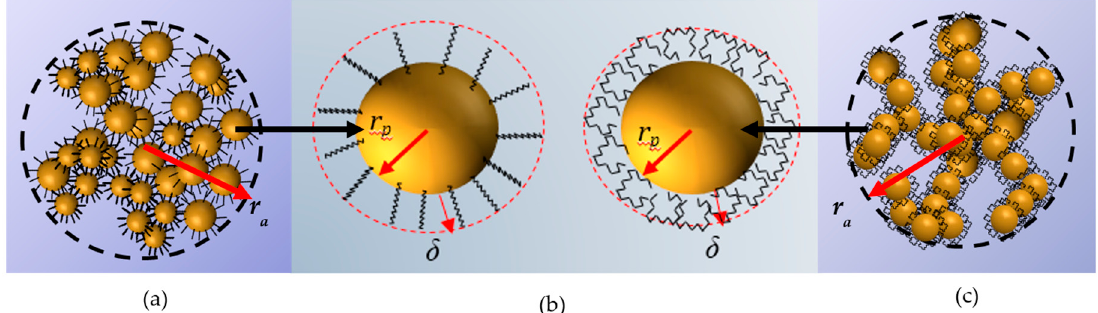
Figure 4. ( a ) Representation of an agglomerate of R816 fumed silica particles in PPG400. ( b ) The hexadecyl silane conformation adopted in each base fluid. In PPG400, the trans conformation (left) leads to a high liquid layer thickness δ surrounding the particle vs. the twisted conformation in PEG200 with a small liquid layer (right). ( c ) Representation of an agglomerate of R816 fumed silica particles in PEG200.